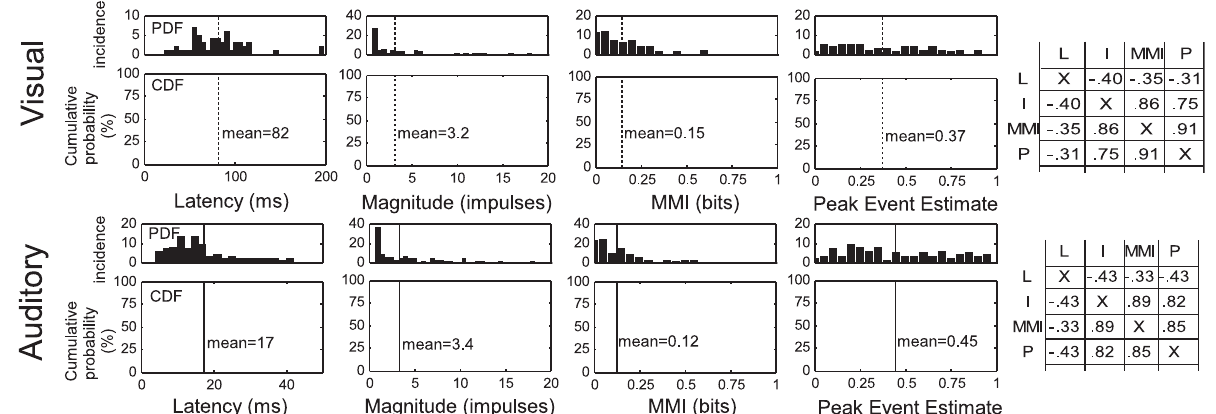
Figure 2. Unisensory response properties of multisensory SC neurons . Shown are the probability distributions (PDFs) and cumulative (probability) distribution functions (CDFs) of the response latency, magnitude, MMI, and peak event estimates for unisensory visual (top, N ¼ 55) and auditory (bottom, N ¼ 90) responses. Dotted lines identify the mean value for each parameter. Shown on the right are the cross-correlations between different parameters (L, latency; I, impulses (magnitude); MMI, maximum mutual information; P, peak event estimate), indicating strong positive correlations between all of the measures except response latency, which showed a weak, but consistent negative correlation (i.e., shorter latency) with the other